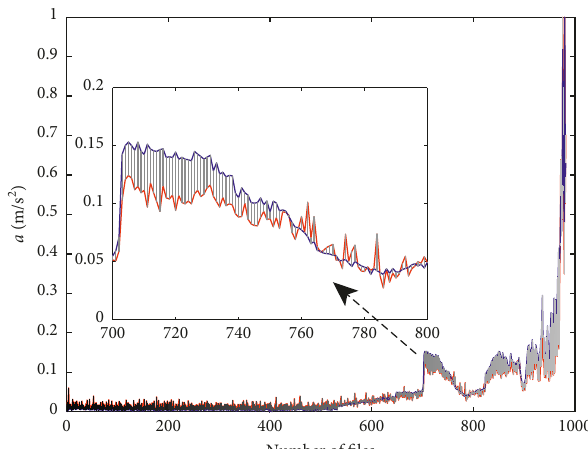
Figure 5: The DFD between the peak-to-peak and RMS of Case I.